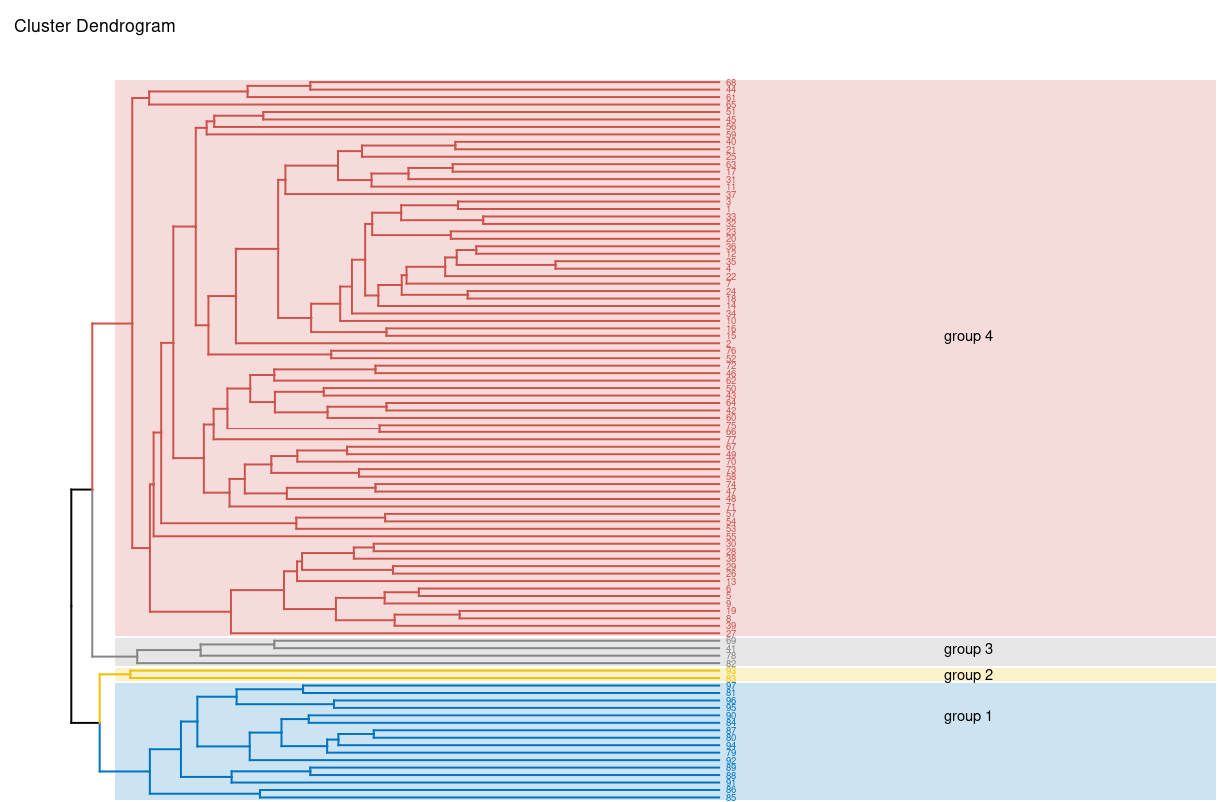
Figure 1. Dendrogram of genetic distances between 97 selected varieties of chrysanthemum based on UPGMA. Using the k-means algorithm, we divided the analyzed collection into four The heat map (Figure S1) visualizes the genetic distance between the studied varieties. The varieties marked in red show a distance equal to or close to 0, i.e., showing the greatest similarity. The genetic distance is greater the closer the color approaches green. Figure S1 reveals a clear distinctiveness of small-flowered cultivars, which are located in the lower left corner of the map. The lowest distance occurs between varieties 4 (Angali) and 35 (Rosee D’une Nuit Rose) (0.196116), while the highest is between 58 (Impact Rood) and 83 (Conaco Orange) (0.960769) (Supplementary Table S3). Conaco Yellow (84) showed the highest genetic distance between as many as 32 cultivars. Another example is cultivar 94 (Sicardo Orange), with 10 varieties of the greatest distance. Varieties 83 and 94 are small-flowered, and the majority of cultivars in the study were medium- flowered and large-flowered, which may be the reason for the increased number of varieties with a significantly increased distance. The pairs of varieties 1 (Alaka) and 3 (Alaka Yellow), 5 (Artistic Armin) and 6 (Artistic Armin Red), 28 (Mount Gerlach) and 29 (Mount Gerlach Yellow), 32 (Romy) and 33 (Romy Rouge), 88 (Jasoda Violet) and 89 (Jasoda Yellow), and 95 (Sicardo Pink) and 96 (Sicardo White) show the smallest genetic distance to each other (Supplementary Table S2). These varieties come from the same series. The only difference is the color of the inflorescences.